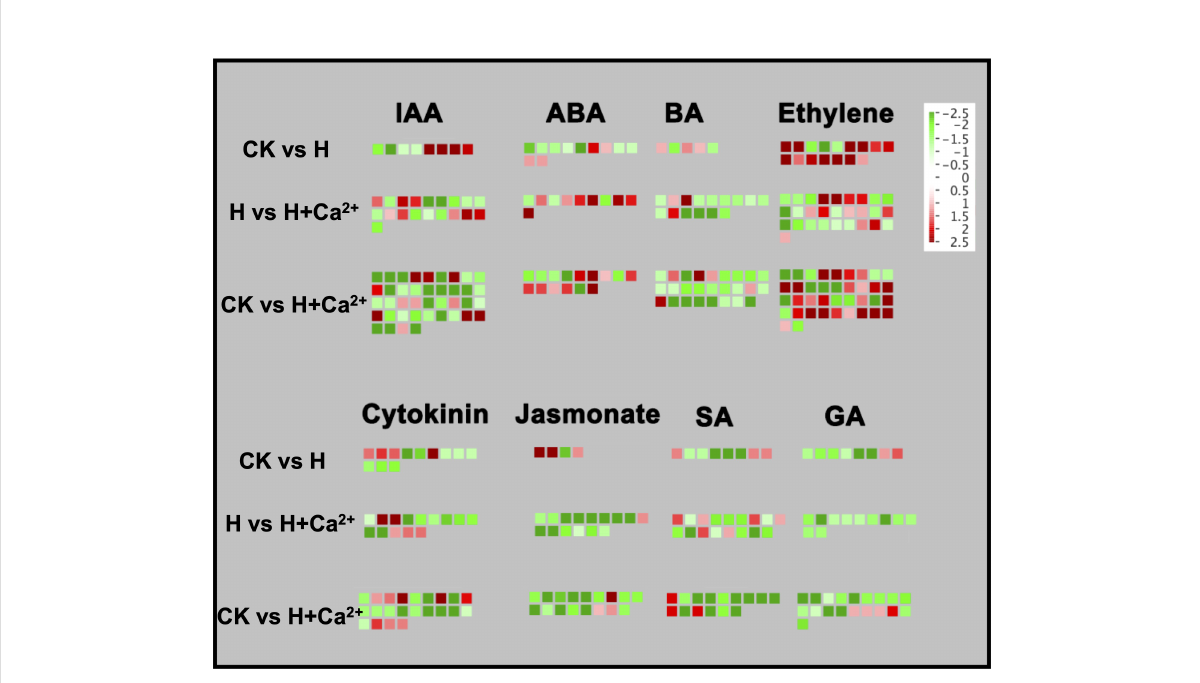
FIGURE 4 Display of gene expression involved in hormone biosynthesis and signaling pathway. Signi fi cantly DEGs (log2 fold changes (FC) ≥ 1, FDR ≤ 0.05) were visualized using Mapman software and organized into functional categories (BINs). Green indicates a decrease and red an increase in gene expression (see color set scale on top right corner). Detailed information on each gene and its expression level is listed in Supplementary Table